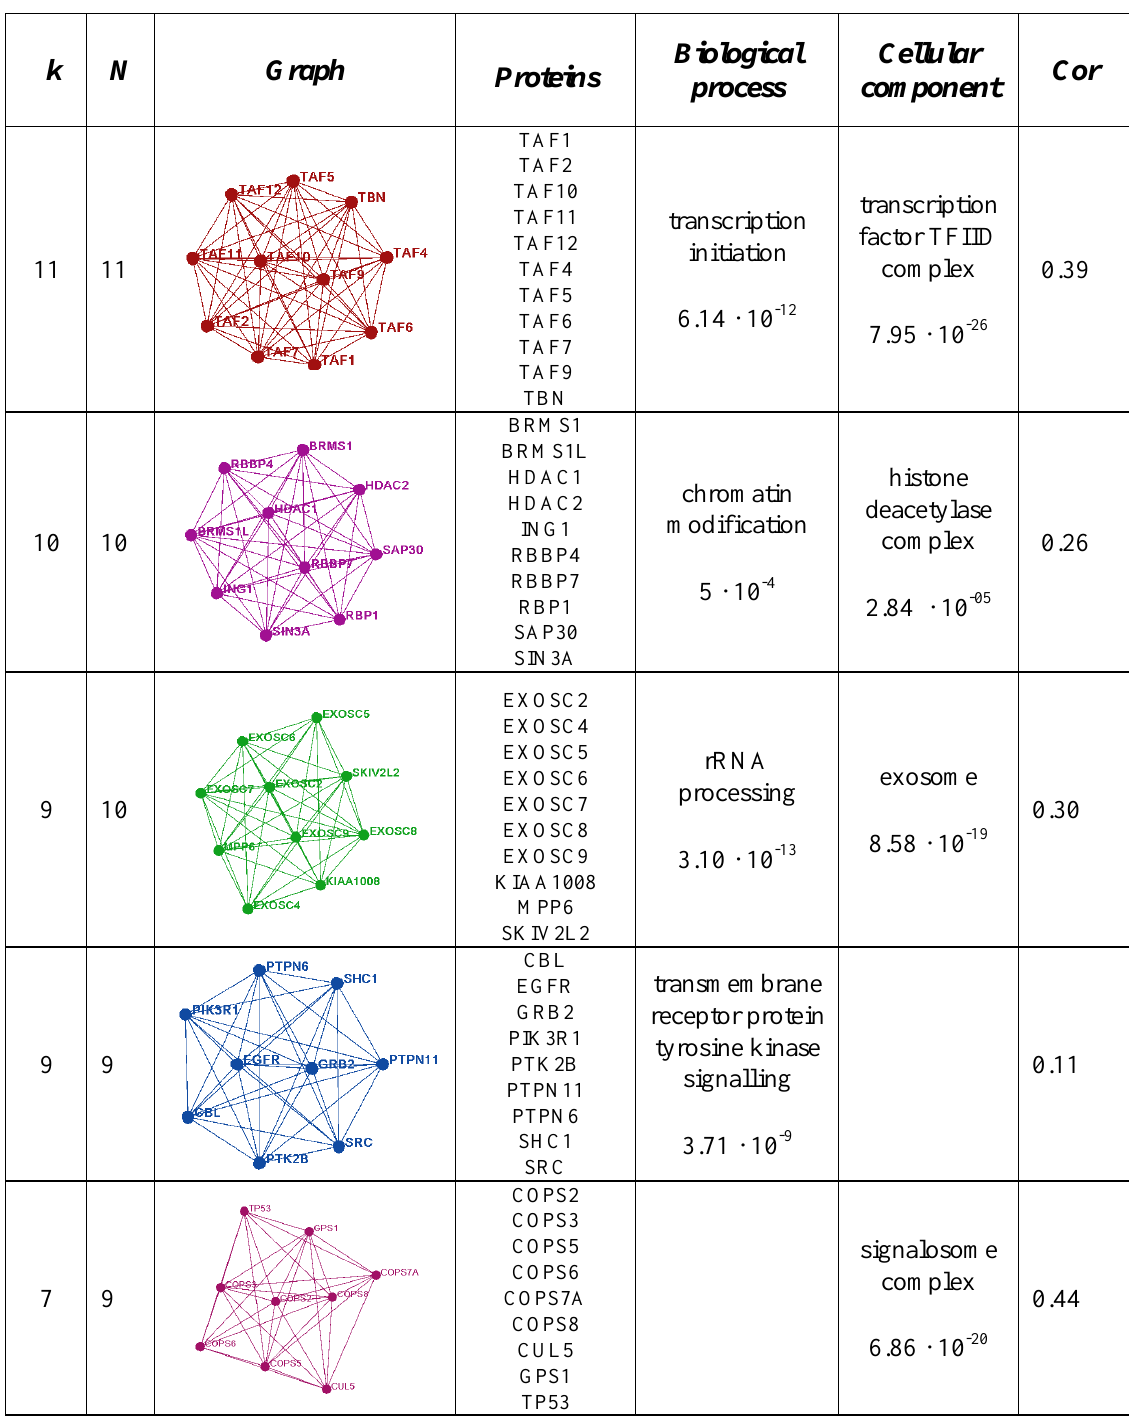
Table 1: Examples of detected protein modules: k - size of cliques, N - number of proteins included in the module, cor - average correlation of expression. The false discovery rates are shown for representative biological processes and cellular